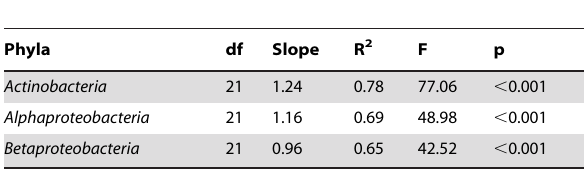
Table 1. Results from generalized linear models (GLM) relating the proportions of different phyla detected in the 454-pyrosequencing and LH-PCR